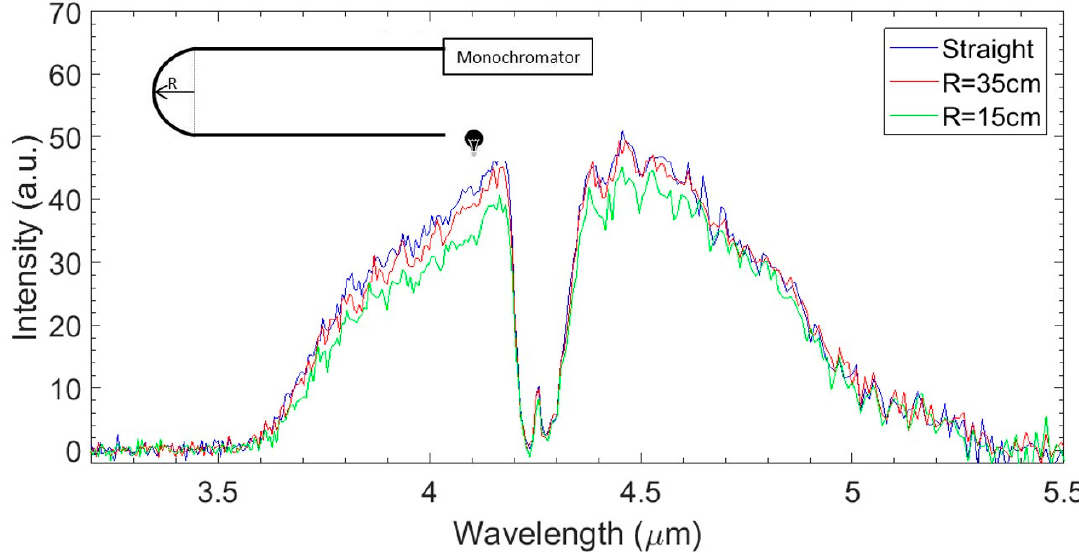
Figure 5. Optical transmission spectrum of 1.3 m of the HC of Figure 4, when the fiber is straight (blue line), bent with a bending radius R of 35 cm (red line, half a turn) and with R = 15 cm (green line, half a turn).